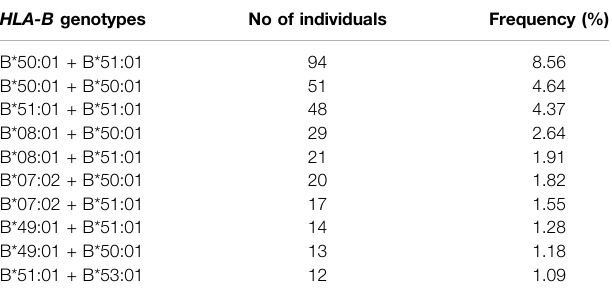
TABLE 3 | Top 10 HLA-B genotypes frequency in Qatari population. HLA-B